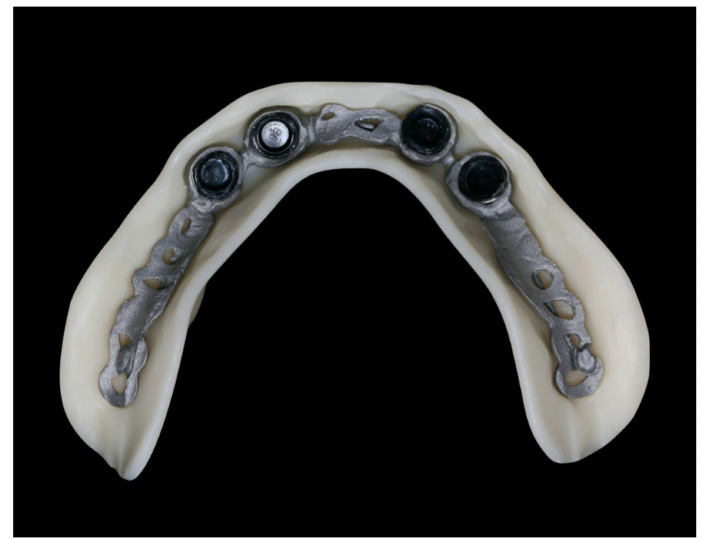
Figure 11. The digitally processed and fabricated alloy framework perfectly fits into the 3D-printed try-in denture in the lower jaw. As no further adjustments were necessary, the digital process simplified both the clinical and laboratory process.